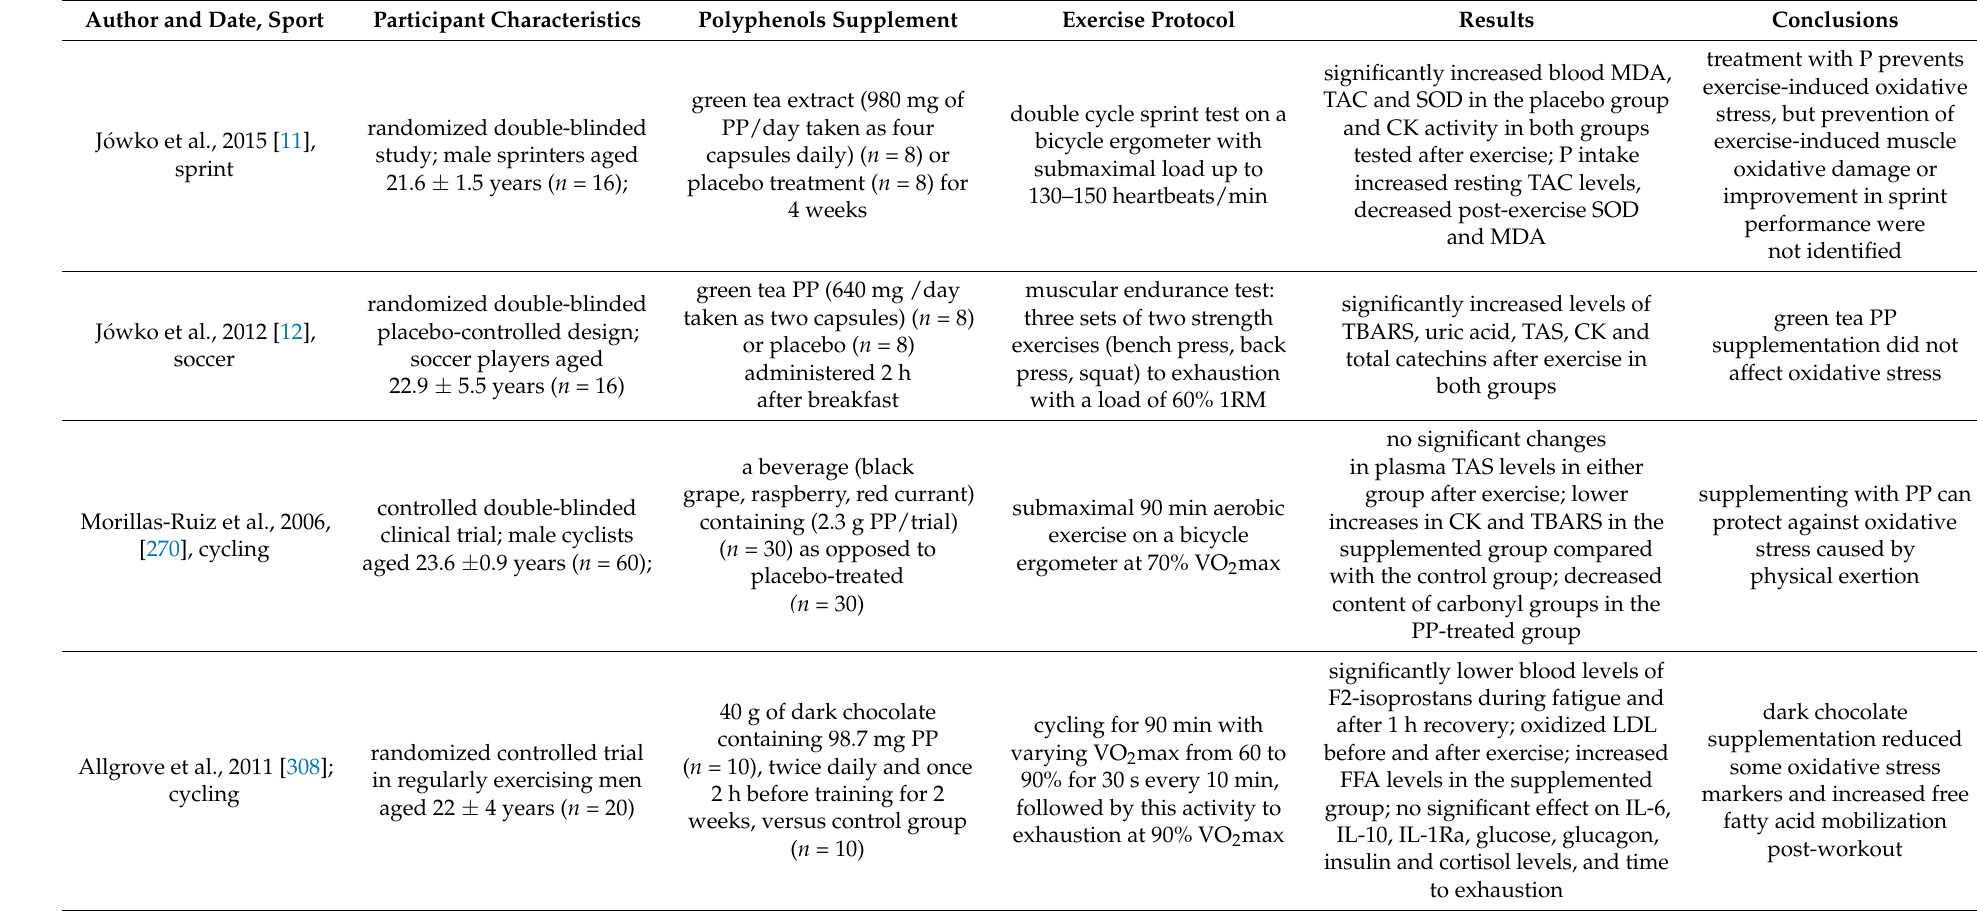
Table 1. Effects of polyphenol-enriched supplementation on oxidative stress induced by heavy exercise training in